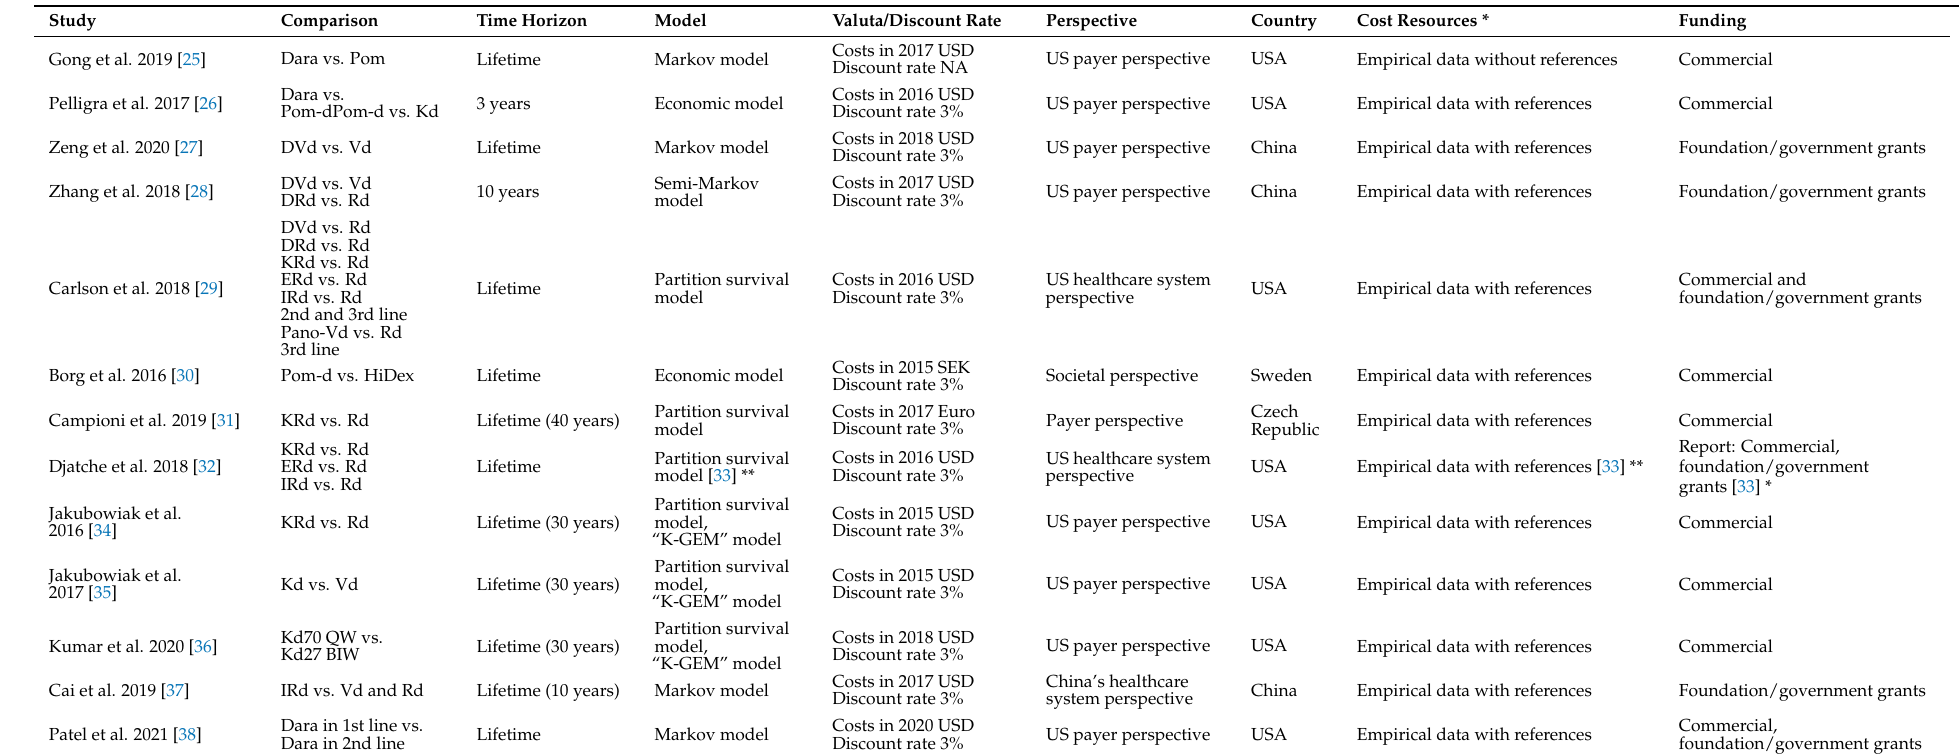
Table 1. Characteristics of the included studies.